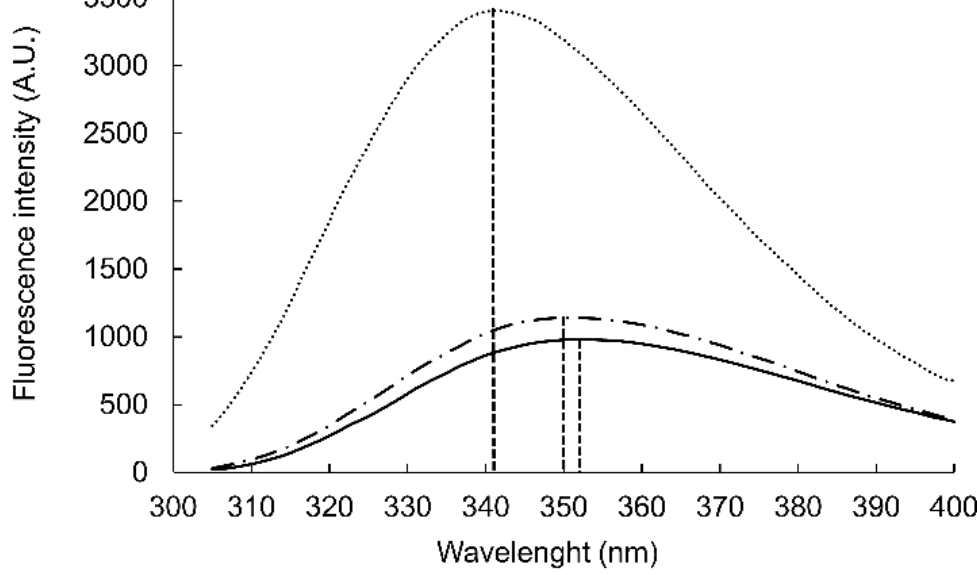
Figure 1. The blue-shift of the tryptophan fluorescence emission in interaction with GM1:DPC micelles. Emission spectra obtained for peptide WYKYW alone (black, 2.5 µM), WYKYW + DPC (DPC 250 µM, dash-dotted), and WYKYW + GM1:DPC (+GM1:DPC 50:250 µM, dotted).